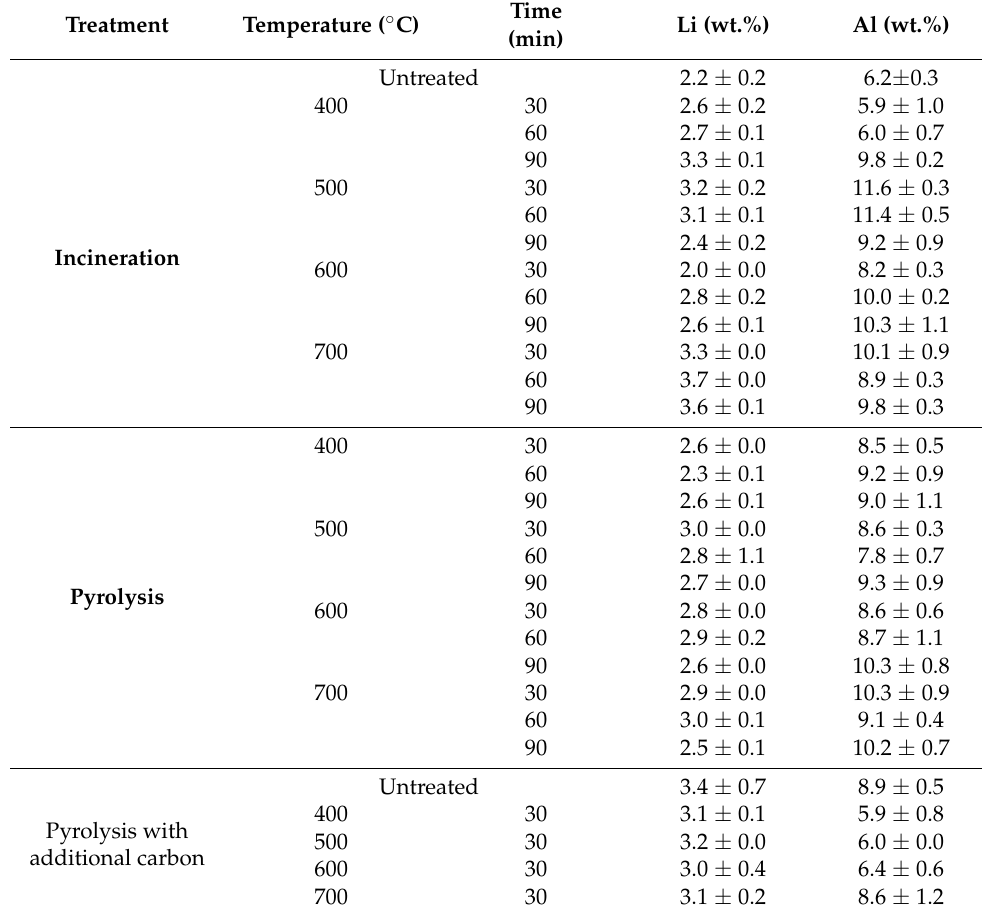
Table 1. Composition of thermally treated samples and untreated